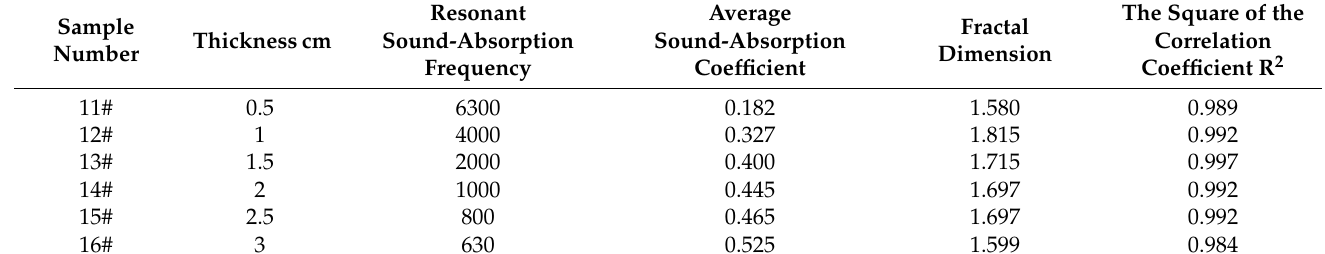
Table 3. Relevant parameters of specimens under different thicknesses.